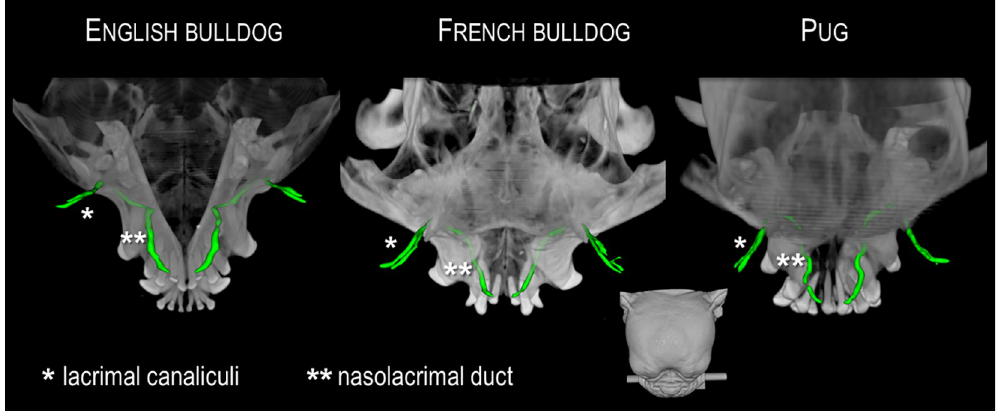
Fig 4. Comparative course of the nasolacrimal drainage system (NDS) in three brachycephalic dog breeds. The NDS is illustrated three-dimensionally, in green color, inside the skull of an English Bulldog, a French Bulldog, and a Pug. The viewing perspective is represented by the head at the bottom of the picture (dorsal view). The backwards orientated parts of the NDS (canaliculi, initial part of the nasolacrimal duct) are smallest in English Bulldogs and largest in Pugs.